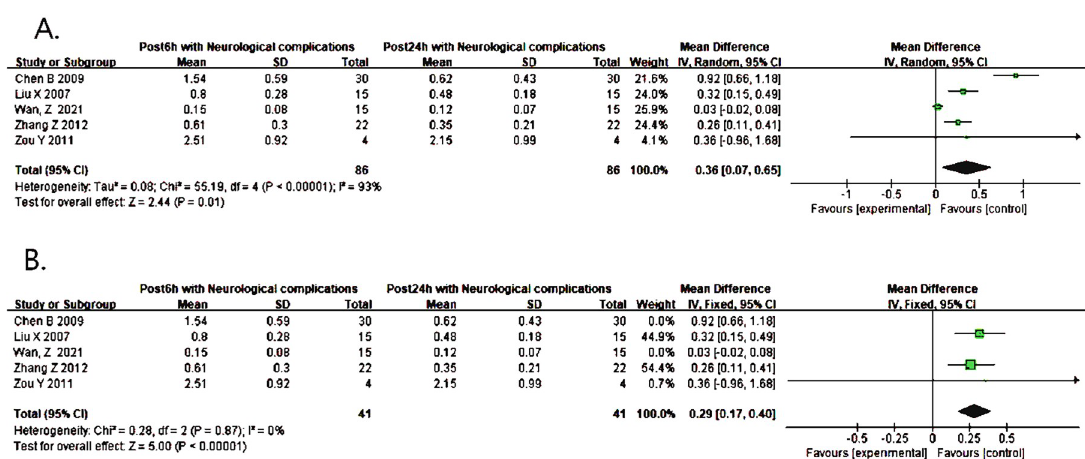
Fig 4. (A) Forest plot of S100B predicting neurological complications at 6 and 24 hours after operation. (B) Forest plot of the pooled result after corrected by the sensitivity analysis.